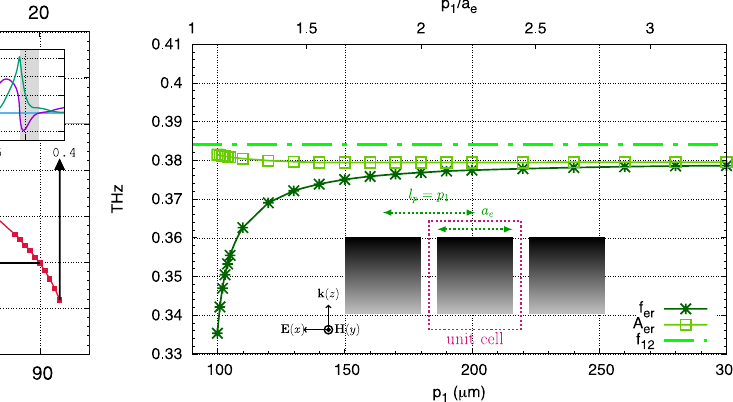
Fig. 3. Frequency mode coupling: minimal value of the effective refractive index n eff as a function of the side length a e of the electric resonator, namely, the frequency of the electric mode is varying. Insets: real (purple) and imaginary part of (green) the effective index n eff ; the shaded area denotes the bandwidth of negative effective index. f 11 and f 12 are the resonances frequencies of the individual resonators (see the text).